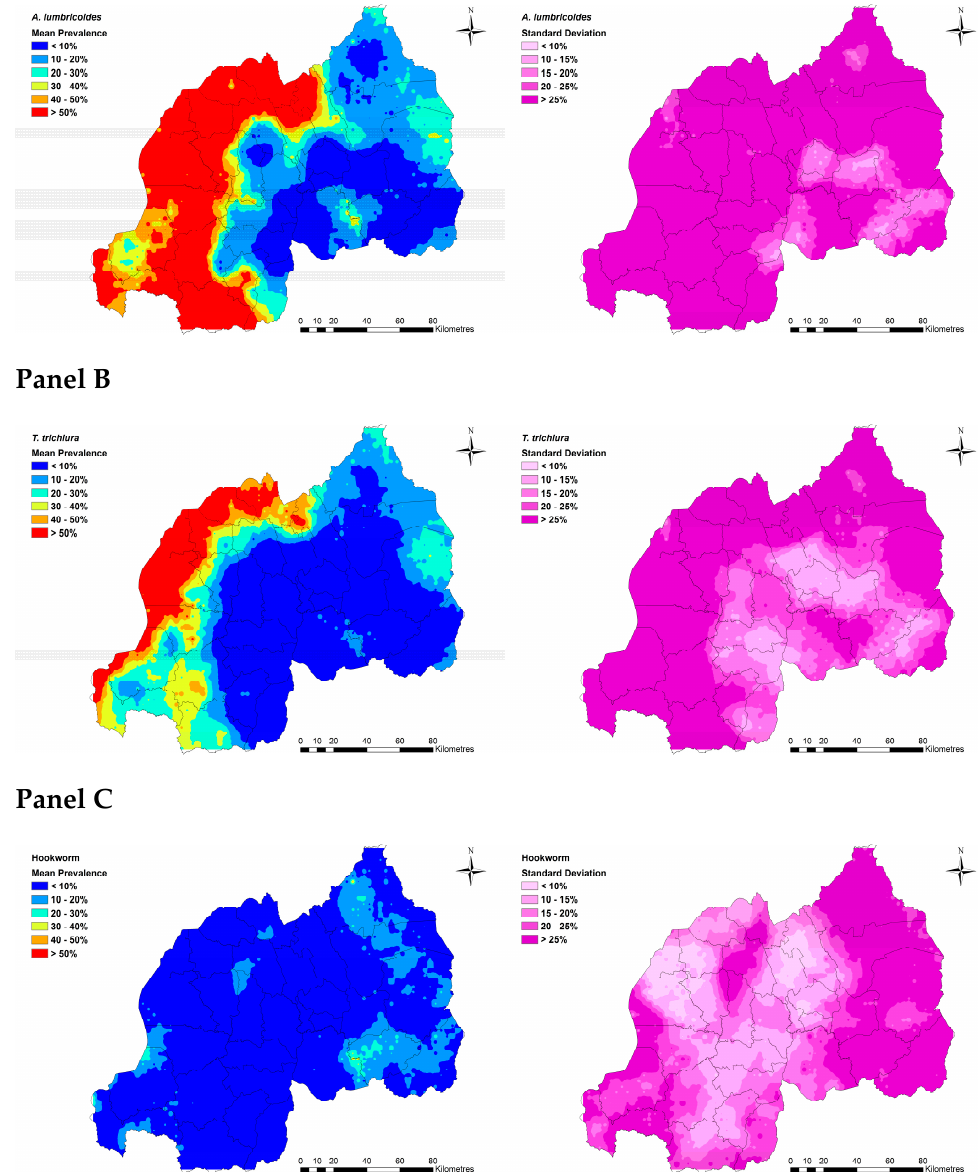
Figure 2. Predicted prevalence of A. lumbricoides ( Panel A ), T. trichiura ( Panel B ), and hookworm ( Panel C ) for boys aged 12–14 years in Rwanda in 2018. Total population raster map is based on population density grid estimated using National Institute of Statistics Rwanda, Fourth Population and Housing Census 2012 data. This figure was produced in ArcMap 10.4 (ESRI, Redlands, CA) using a shapefile representing Rwanda’s current administrative units (obtained from the data warehouse DIVA GIS).